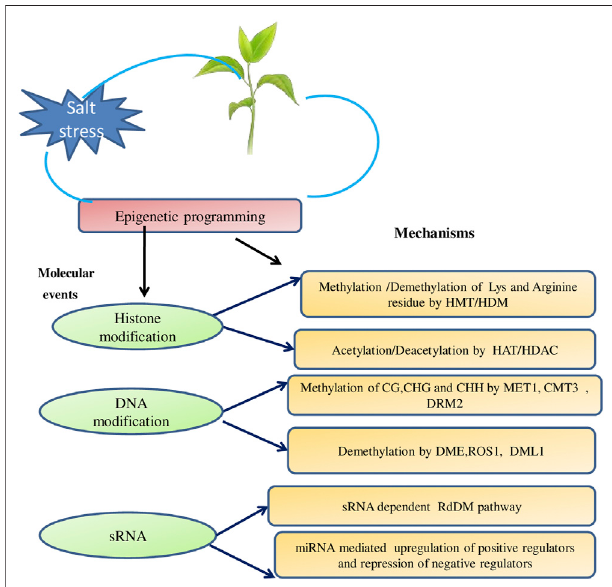
FIGURE 1| Schematic representation ofepigenetics re-programming in plantsexposedtosalinitystressatthreelevel,i.e.,DNAmodi fi cations,Histone modi fi cations and small